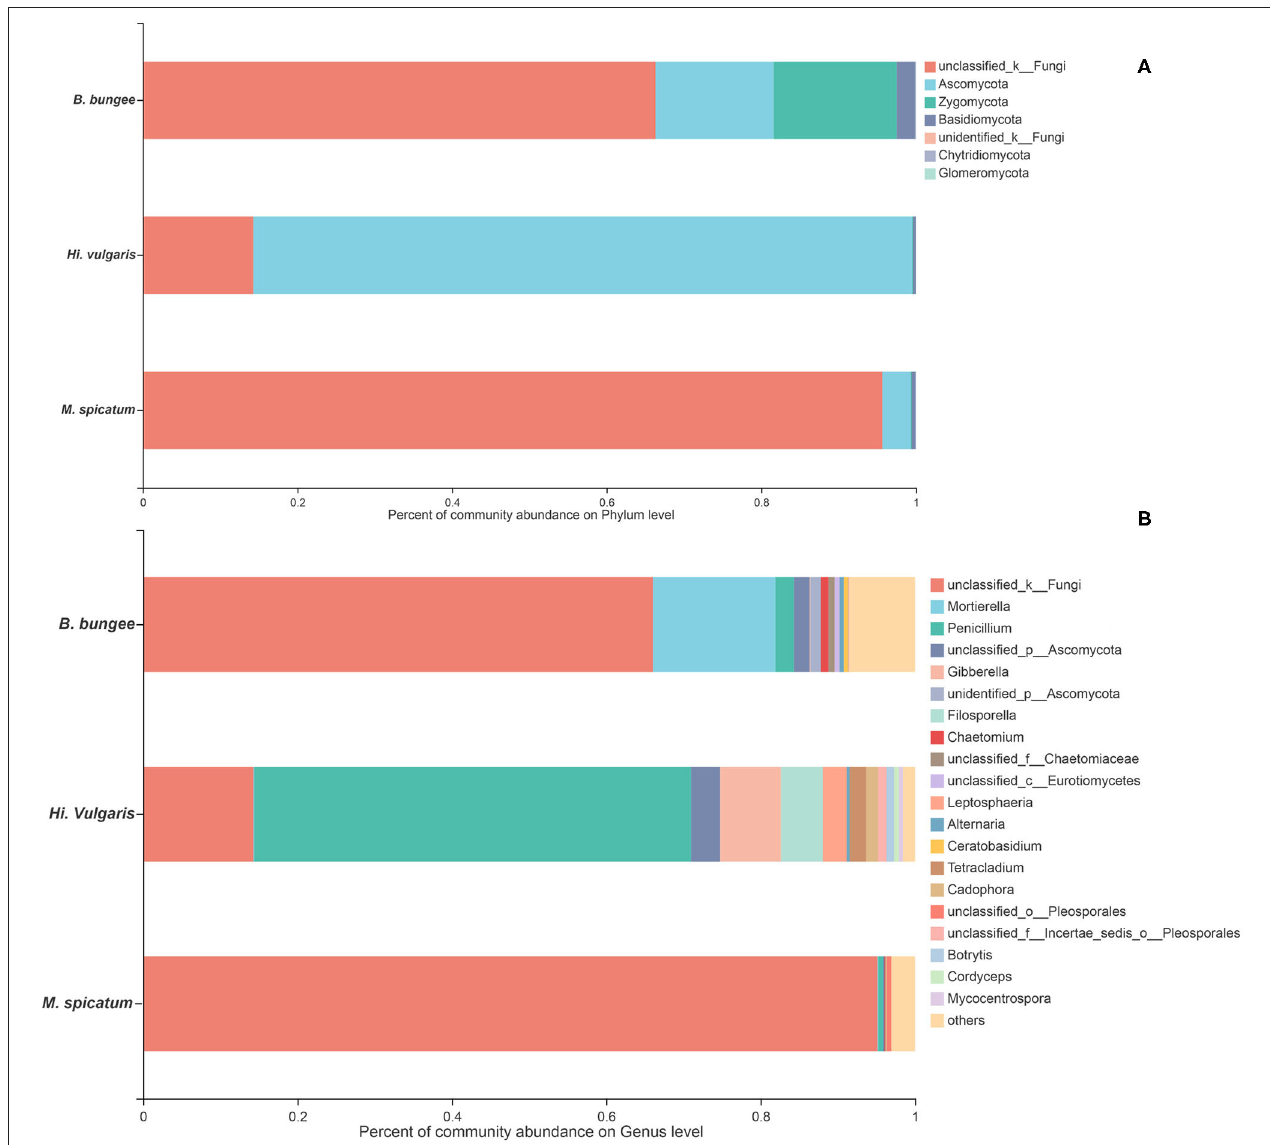
FIGURE 3 | Relative abundance of endophytic fungi in three aquatic plants collected from sampling site LTII at the phylum level (A) and genus level (B) . When the relative abundance was < 0.005%, they were merged together into the “others”